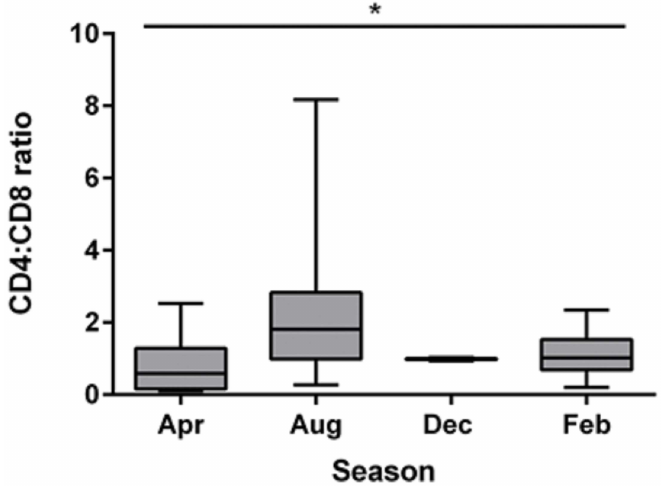
Fig 2. Seasonal difference in CD4:CD8 ratio. * p < 0 . 05 Kruskal-Wallis one-way ANOVA. Ratio calculated after CD4 and CD8 results were calculated using the Δ Cq method [43]. Box represents the 25 th to 75 th percentiles, middle line is median and whiskers are the minimum to maximum